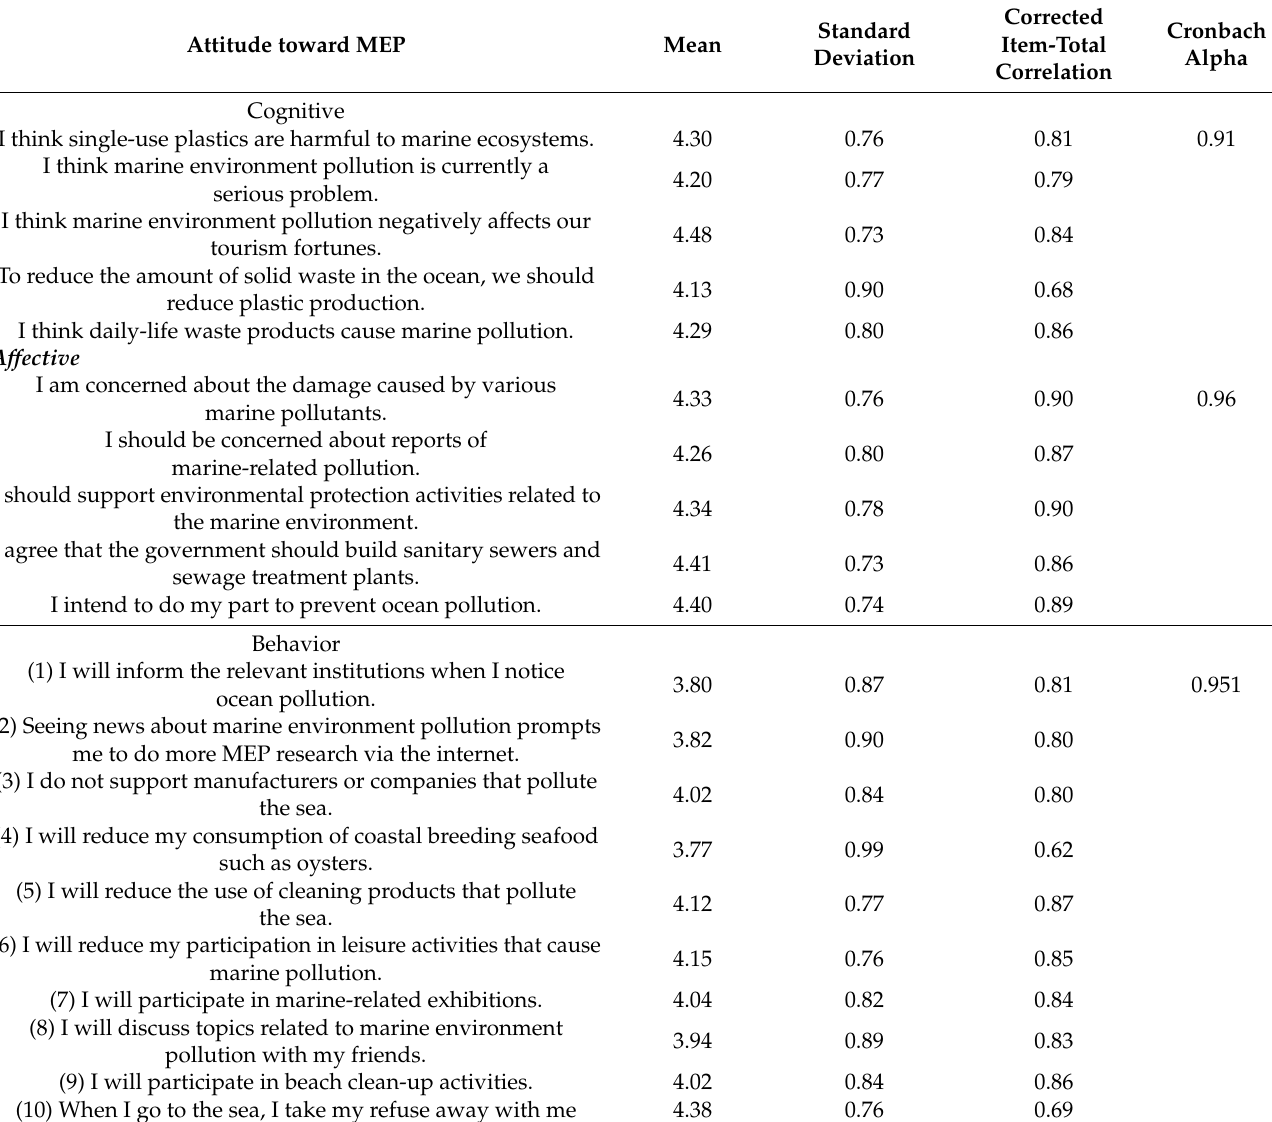
Table 2. University students’ attitudes toward marine environment pollution